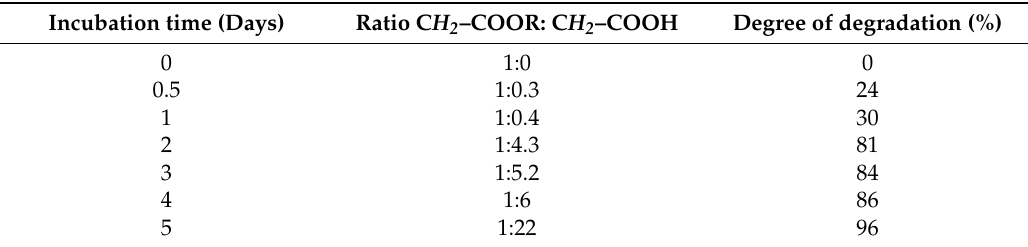
Figure 5 . Overlay of magnified 1 H NMR spectra in DMSO-d 6 of CMS nanocarriers after incubation with CAL B at 32 °C at various time points during a five-day study; simultaneous decrease of –C H 2 –COOR at 2.27 ppm and increase of –C H 2 –COOH at 2.15 ppm. Table 2. Degree of degradation of CMS nanocarriers by incubation with CAL